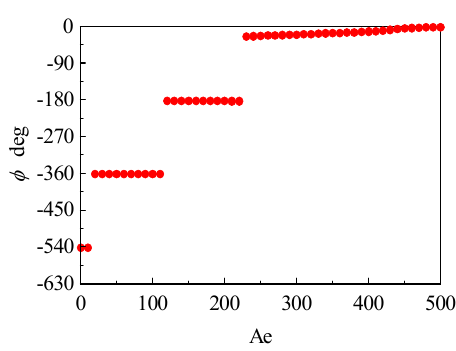
Fig.14 Effect of Ae on the director angle at the upper plate for